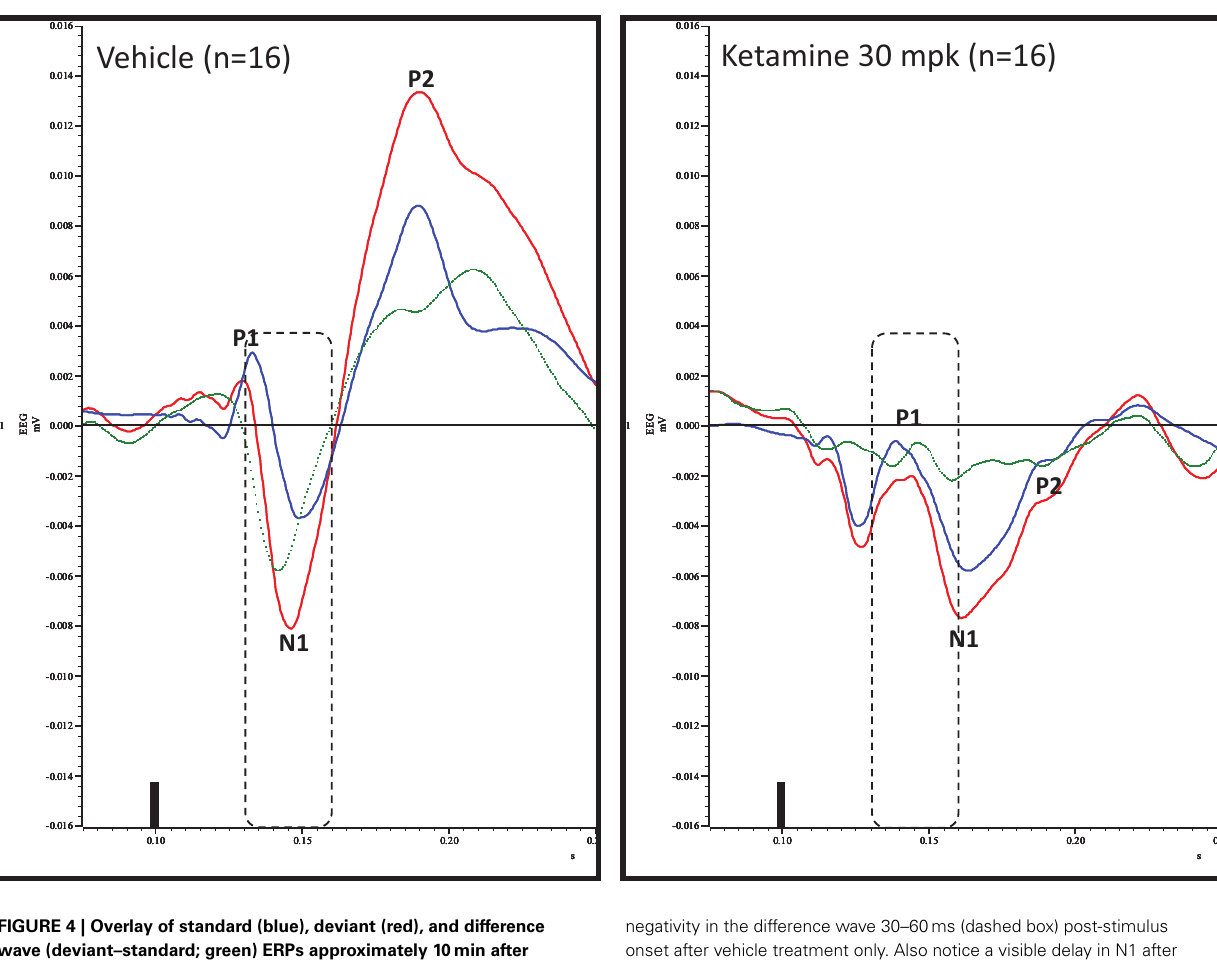
negativity in the difference wave 30–60ms (dashed box) post-stimulus onset after vehicle treatment only. Also notice a visible delay in N1 after ketamine